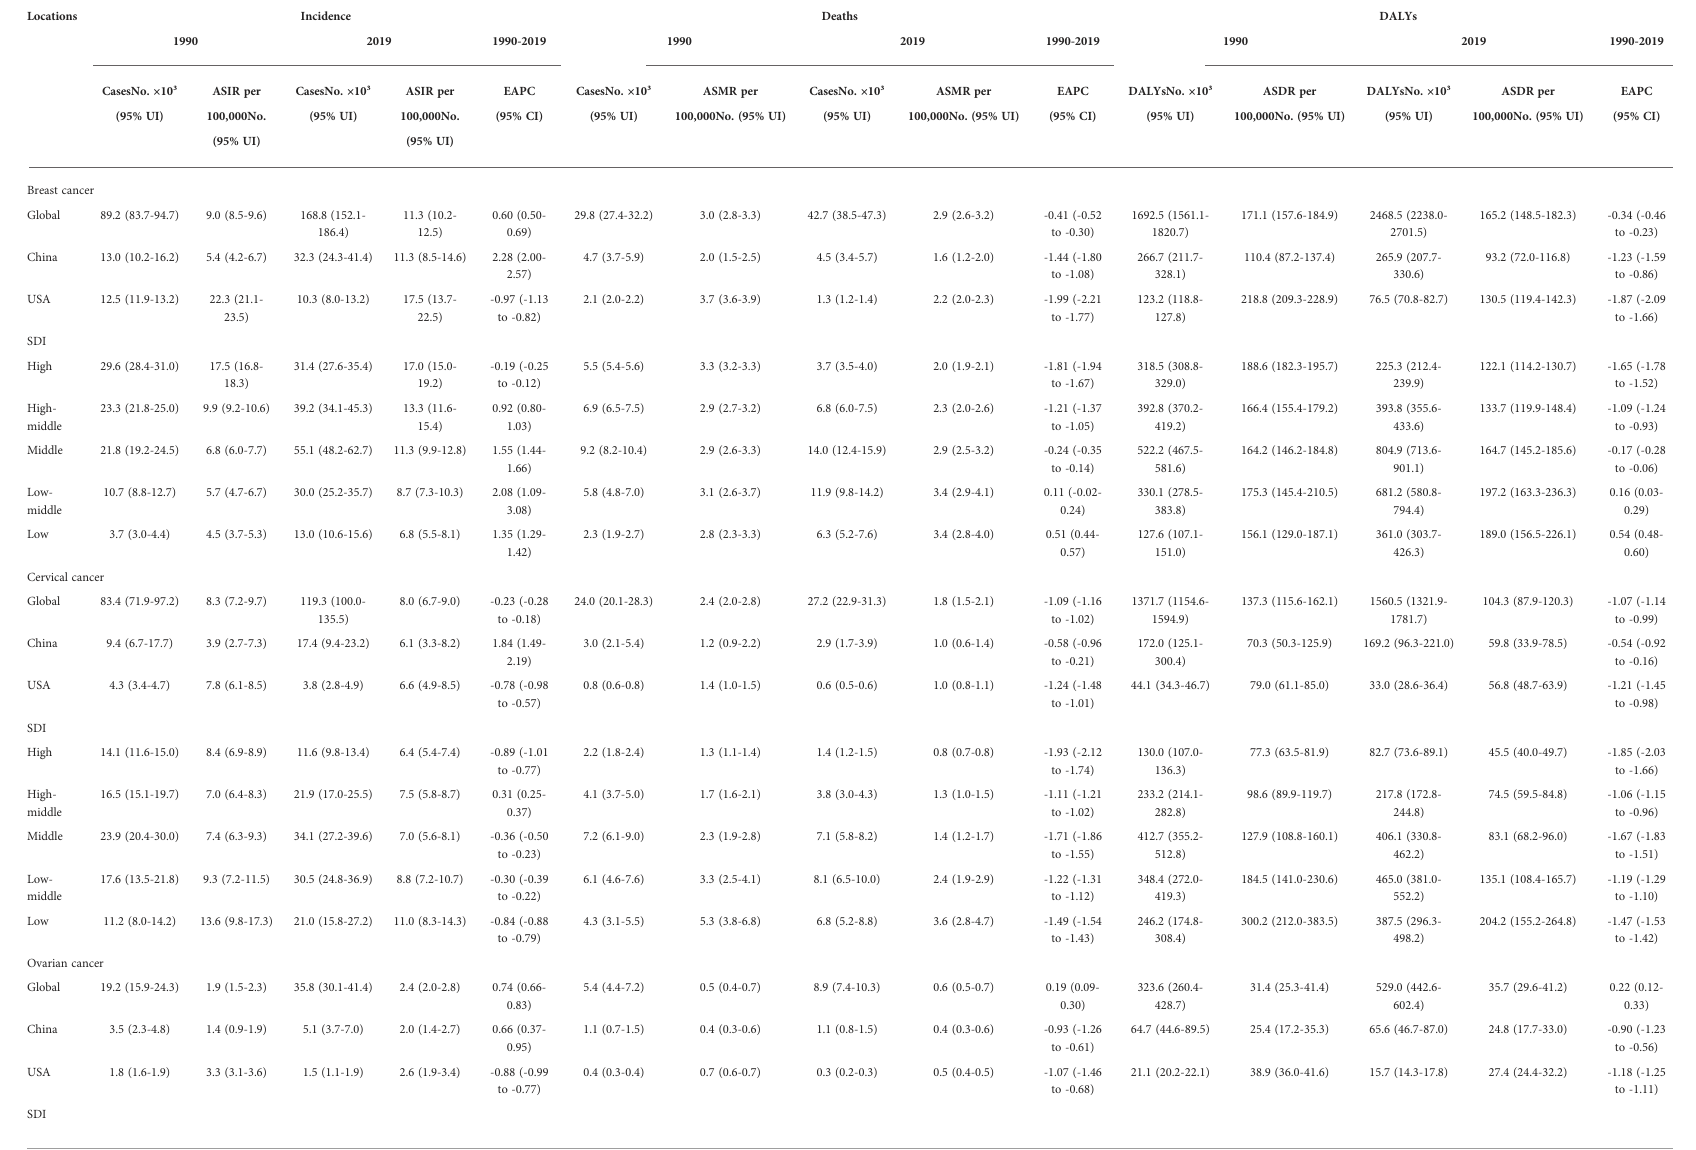
TABLE 1 The incidence, mortality, DALYs, and age-standardized rates, and their temporal trends of FeBGCs among AYAs.